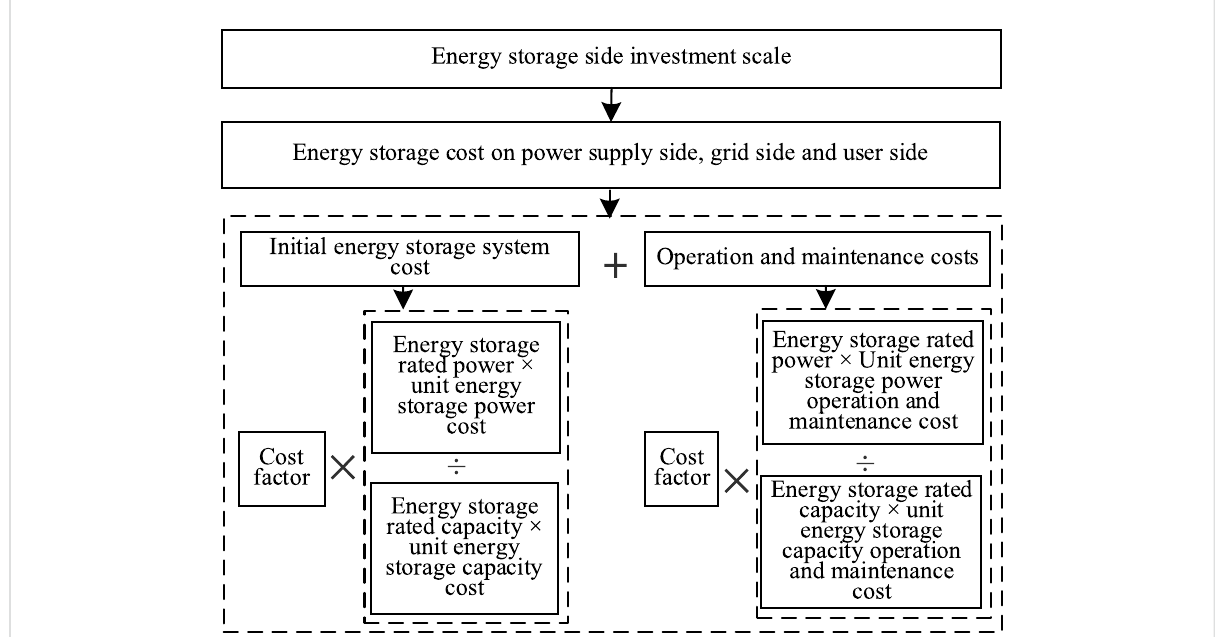
FIGURE 8 Calculation fl ow chart of investment scale of energy storage side in the future.